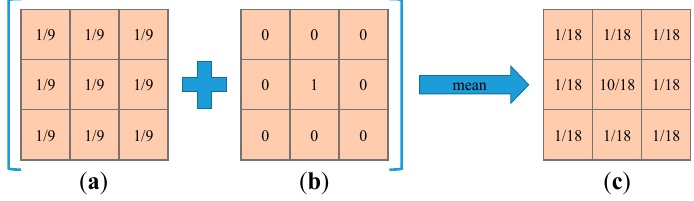
Figure 7. The mask ( c ) is used in the smoothing preprocessing, which is the mean of ( a ) and ( b ). ( a ) is a fundamental mask for smoothing, and mask ( b ) is self-mapping.